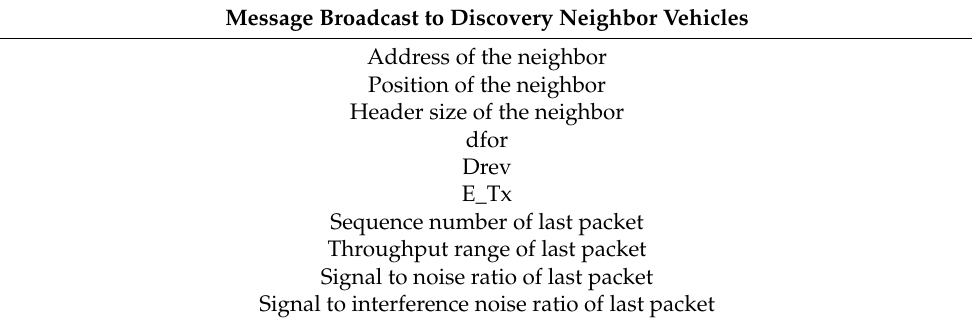
Table 3. Neighbor entry for MAC-based Neighbor Discovery Process.